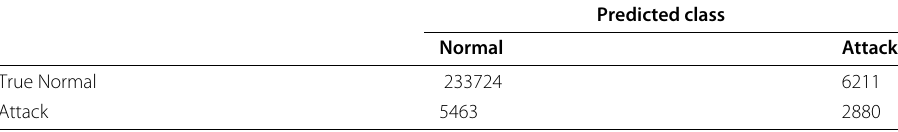
Table 13 Results of the unsupervised anomaly detection approach: confusion matrix resulting when applying the model to test